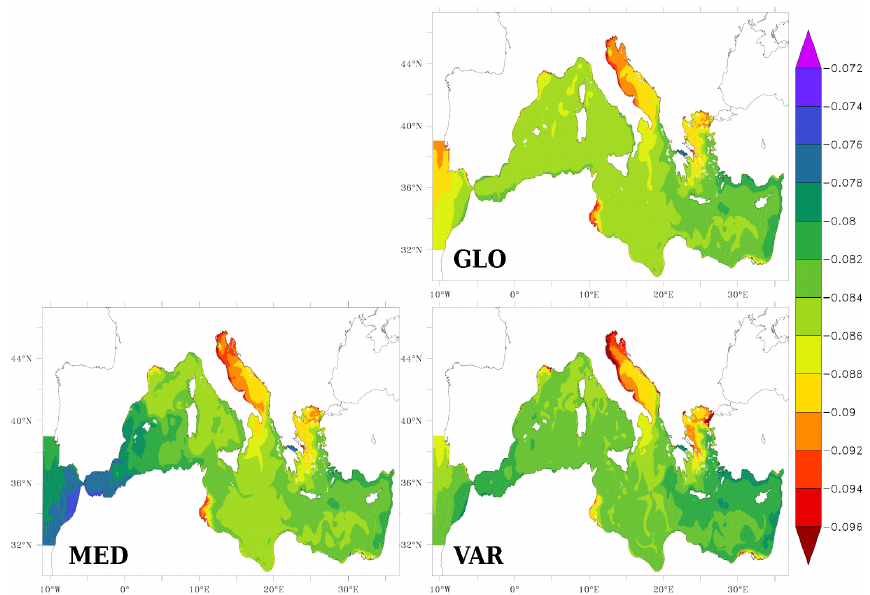
Figure 12. Anthropogenic change in surface pH between 1800 and 2001 for the GLO (top), MED (bottom left), and VAR (bottom right) simulations.